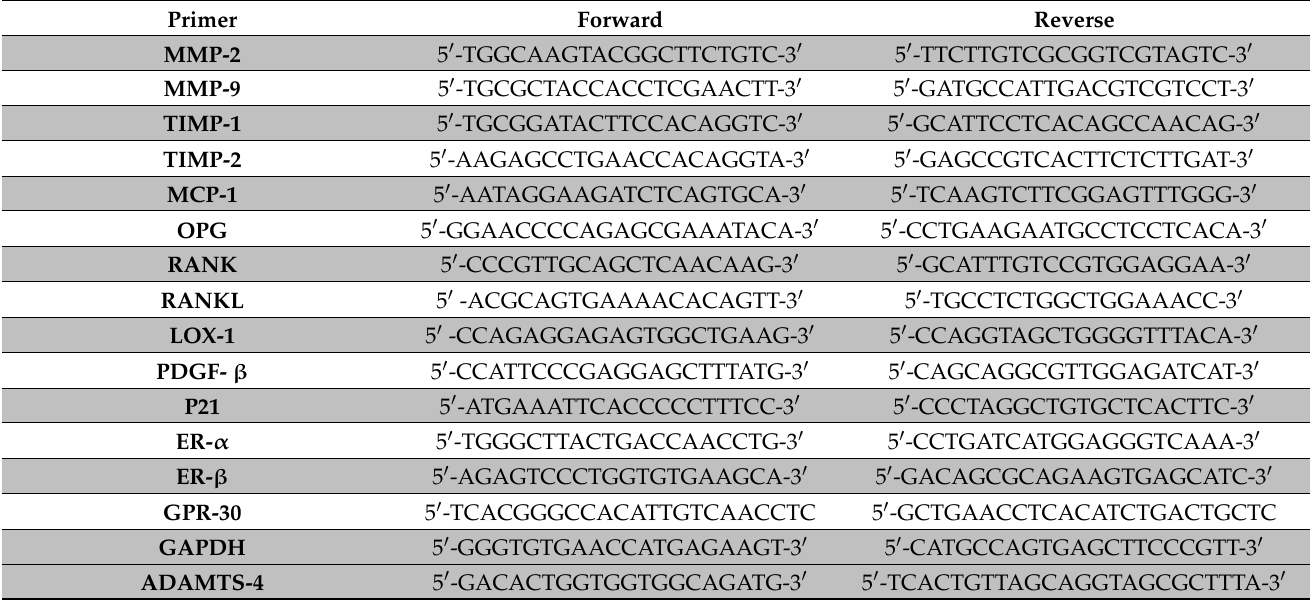
Table 1. The sequences of primers used for the qRT-PCR